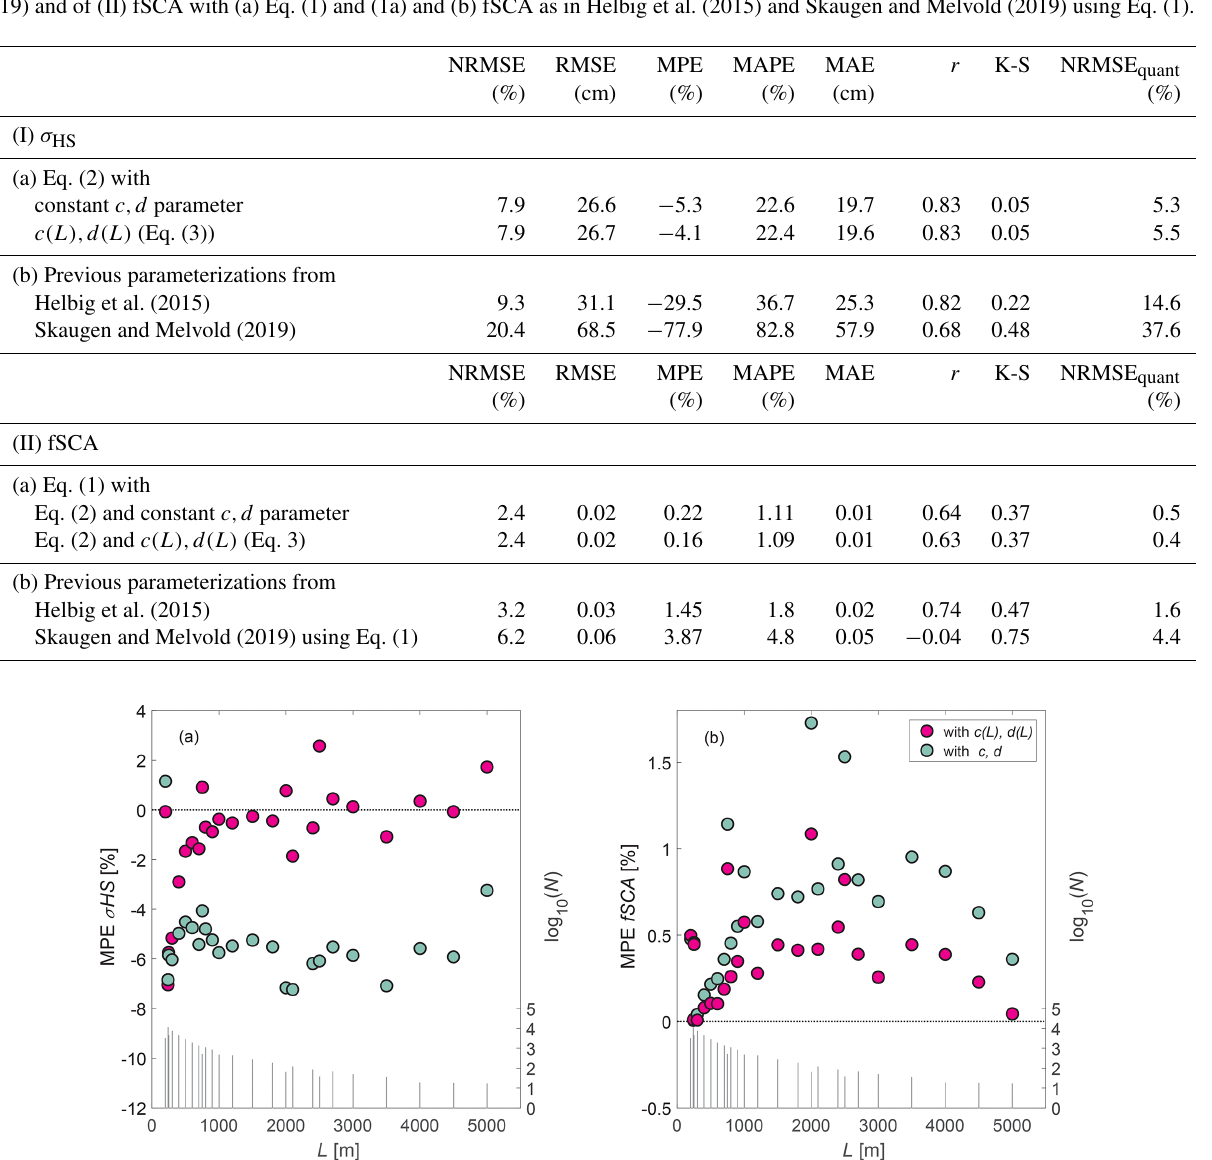
Figure 10. Mean percentage error (MPE) as a function of L for (a) σ HS and (b) fSCA. MPEs are shown for the σ HS and fSCA parameteriza- tions using Eq. (1) to (3) with scale-dependent c(L),d(L) , as well as for constant c,d . The second y axis shows the number of valid domains per L on a logarithmic